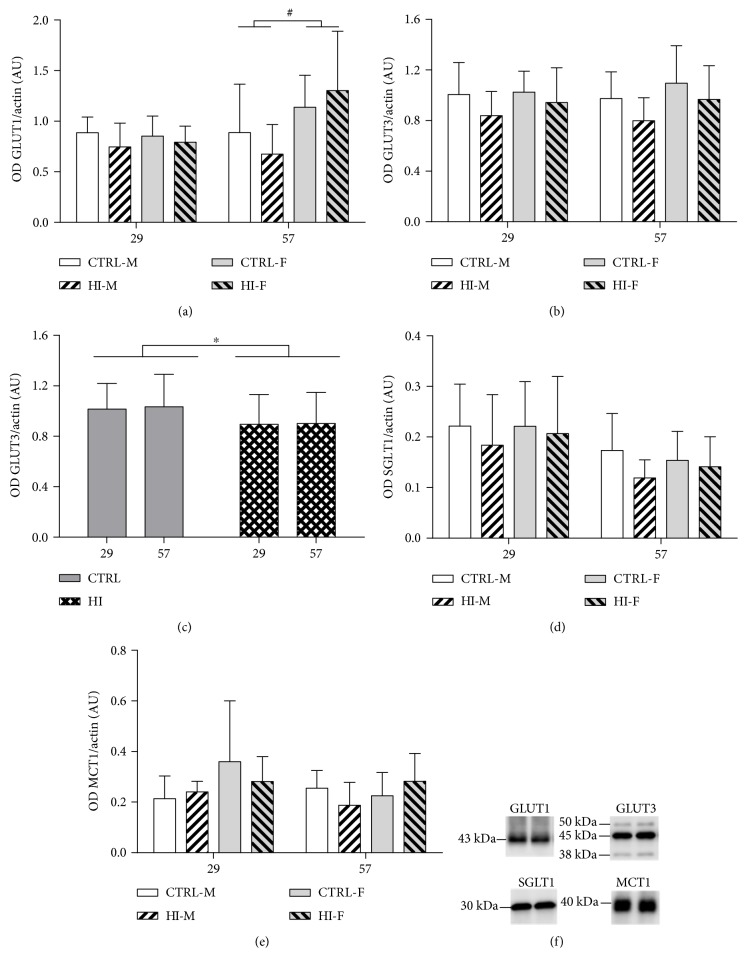
Relative protein levels of substrate transporters at the two different time points during infusion. Mean + SD. (a) GLUT1, each day depicted separately, (b) GLUT3, each day depicted separately, (c) GLUT3, overall effect of HI-dosing, sex pooled. (d) SGLT1 and (e) MCT1, each day depicted separately. (f) Representative pictures of the western blots. CTRL-M: n = 7 − 10, HI-M: n = 4 − 8, CTRL-F: n = 6 − 9, and HI-F: n = 6 − 10. OD: optical density, AU: arbitrary units. Actin levels were used as an internal reference. ∗p < 0.05 for effect of treatment; #p < 0.05 for effect of sex.